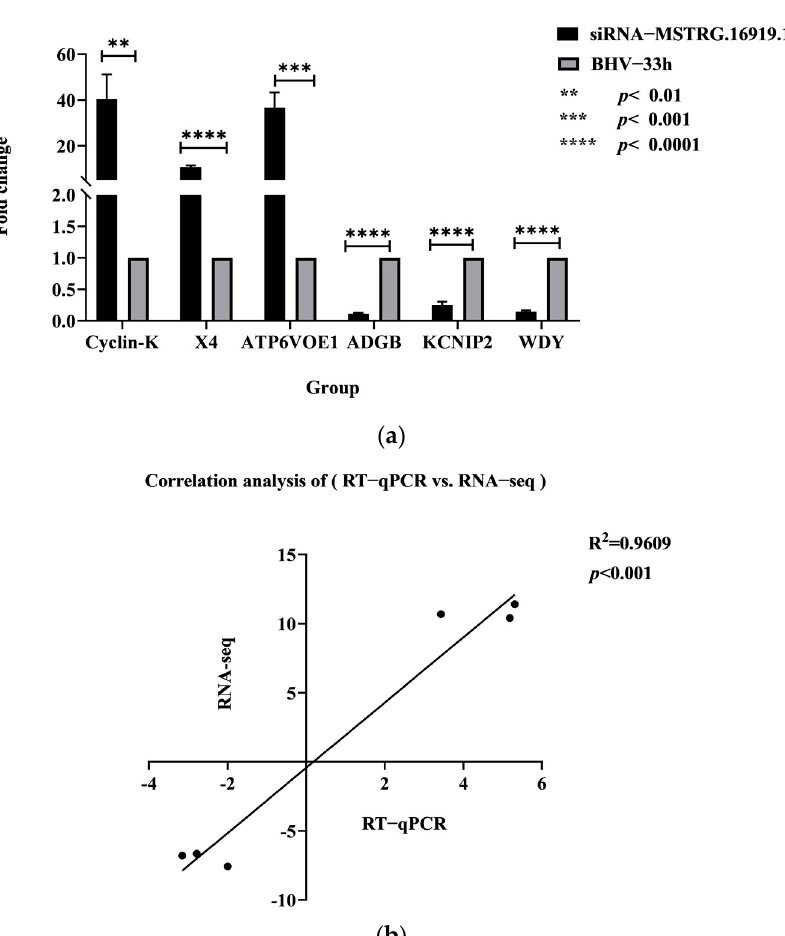
Figure 4. RT − qPCR verification results. ( a ) The abscissa denotes the name of the genes and the ordinate denotes the multiple of difference. The first three genes are upregulated and the last three genes are downregulated. ( b ) Correlation analysis of (RT − qPCR vs. RNA − seq).